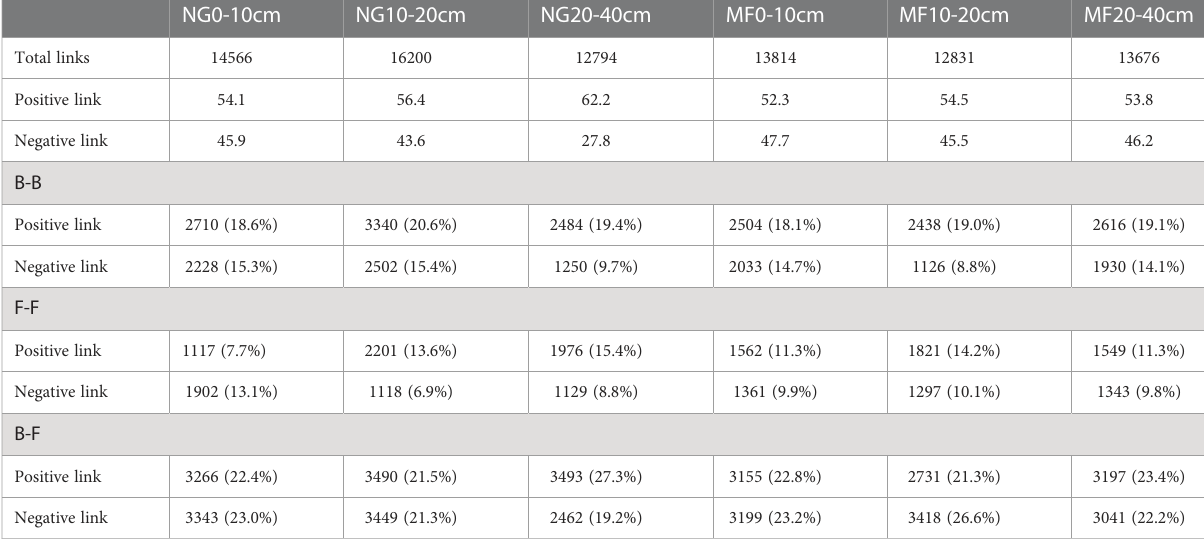
TABLE 2 Numbers of links in the networks of B-B (Bacterial-Bacterial), B-F (Bacterial-Fungi), and F-F (Fungi-Fungi) obtained for soil samples under different treatments (NG, natural grass; MF, planting ryegrass and mowing as feed) at different depths (0 – 10 cm,10 – 20 cm, and 20 – 40